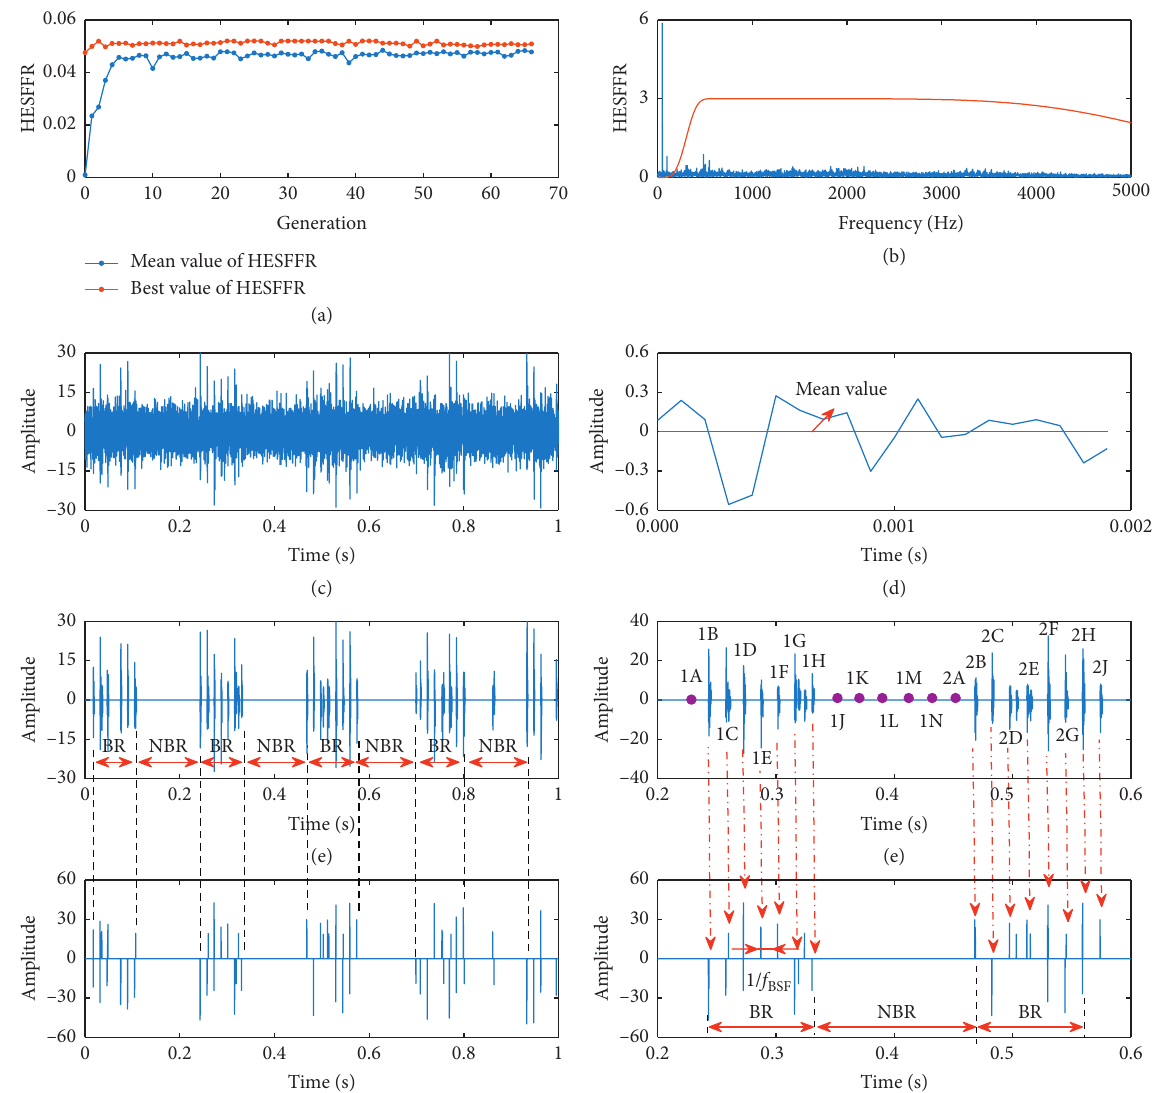
Figure 24: AUC-DLA-OB for identification of wheelset bearing roller fault. (a) Convergence process of solving constrained optimization problems; (b) filtering frequency band related to fault impulses; (c) filtered signal by filters in Figure 24(b); (d) learned shock responses; (e) sparse reconstruction signal; (f) locally zoomed figure of the impulses shown in Figure 24(e); (g) obtained location coefficients; and (h) locally zoomed figure of the location coefficients shown in Figure 24(g).